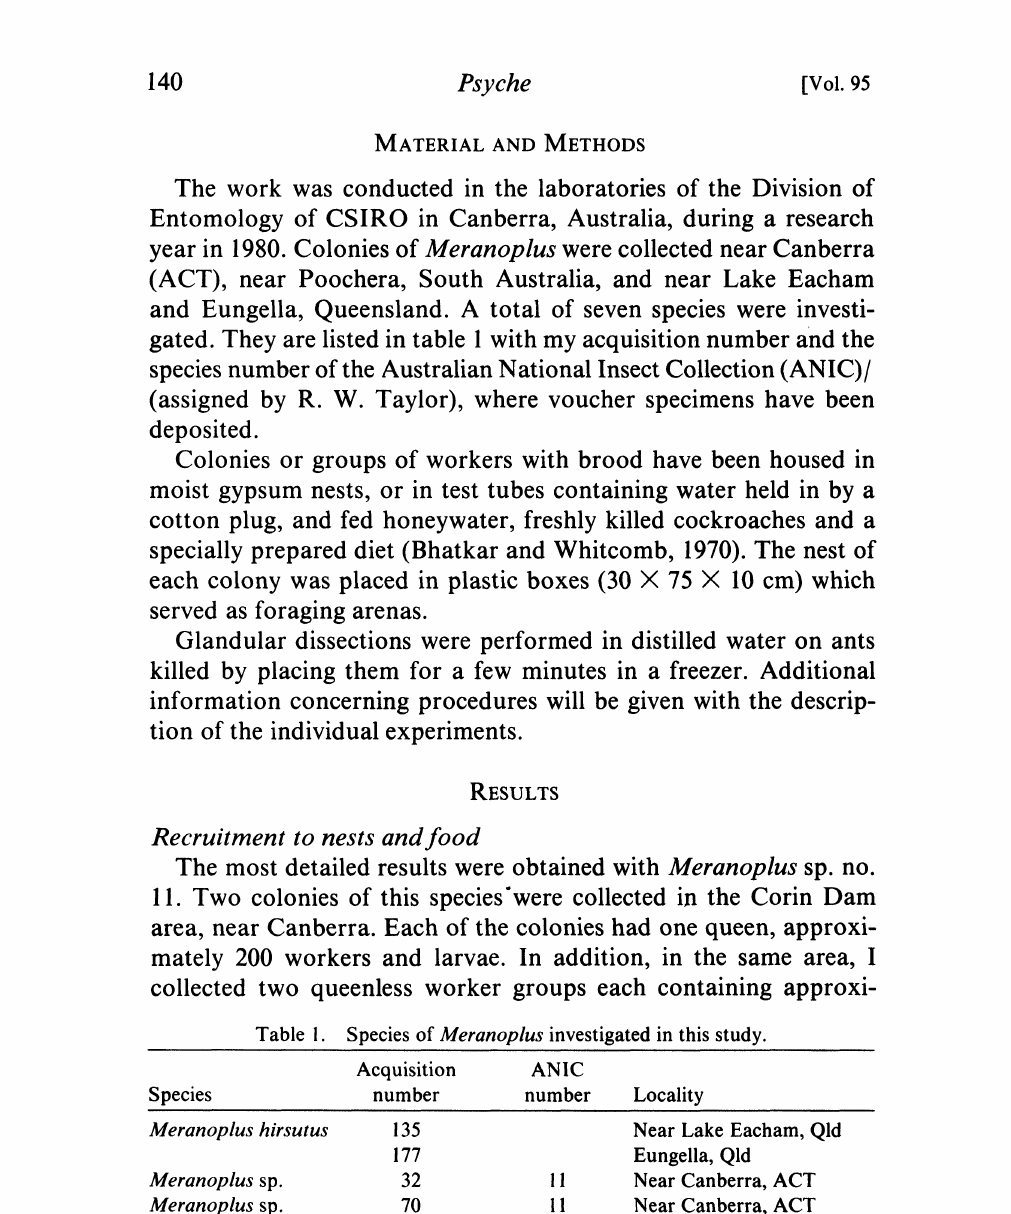
Table I. Species of Meranoplus investigated in this